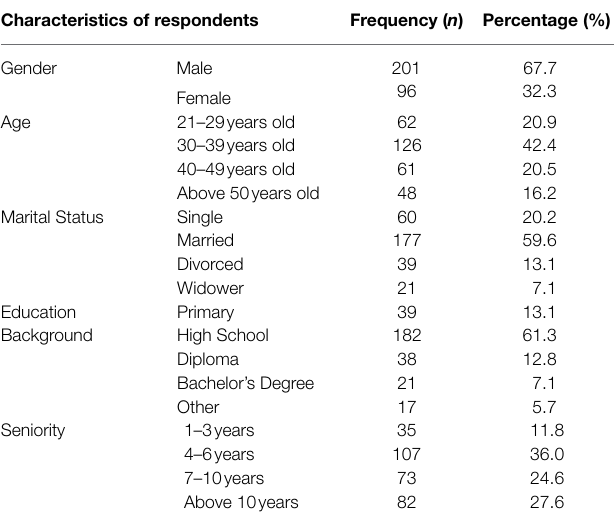
TABLE 1 | Description of the